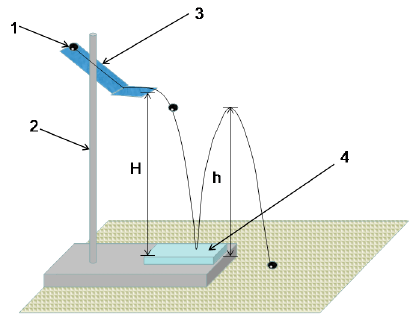
Figure 3. Schematic diagram of slant plate flat throw test system.